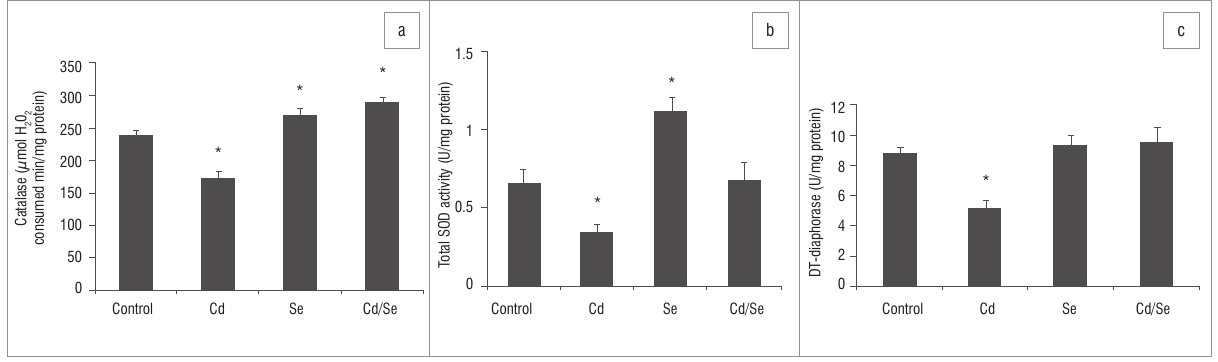
*Statistically significantly different from control at p<0.05. Figure 5: Mean±SD (a) catalase, (b) total superoxide dismutase (SOD) and (c) DT-diaphorase activities in the kidneys of male rats ( n =5) that received cadmium (1.67 mg/kg cadmium chloride in saline), selenium (0.23 mg/kg sodium selenite solution), cadmium and selenium (Cd/Se; 1.67 mg/kg cadmium chloride in saline and 0.23 mg/kg sodium selenite solution) or saline (control) daily (IP) for 15